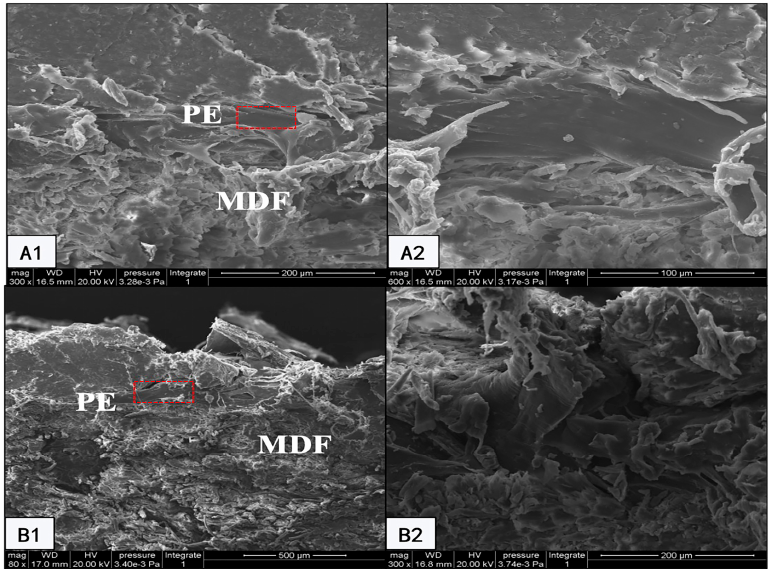
Figure 6. Bonding interface between PE reinforced Fraxinus mandshurica veneer and MDF. ( A1 ) Initial MC of the veneer was 20%, ×300; ( A2 ) Initial MC of the veneer was 20%, ×600 ; ( B1 ) Initial MC of the veneer was 50%, ×80; ( B2 ) Initial MC of the veneer was 50%, ×300.